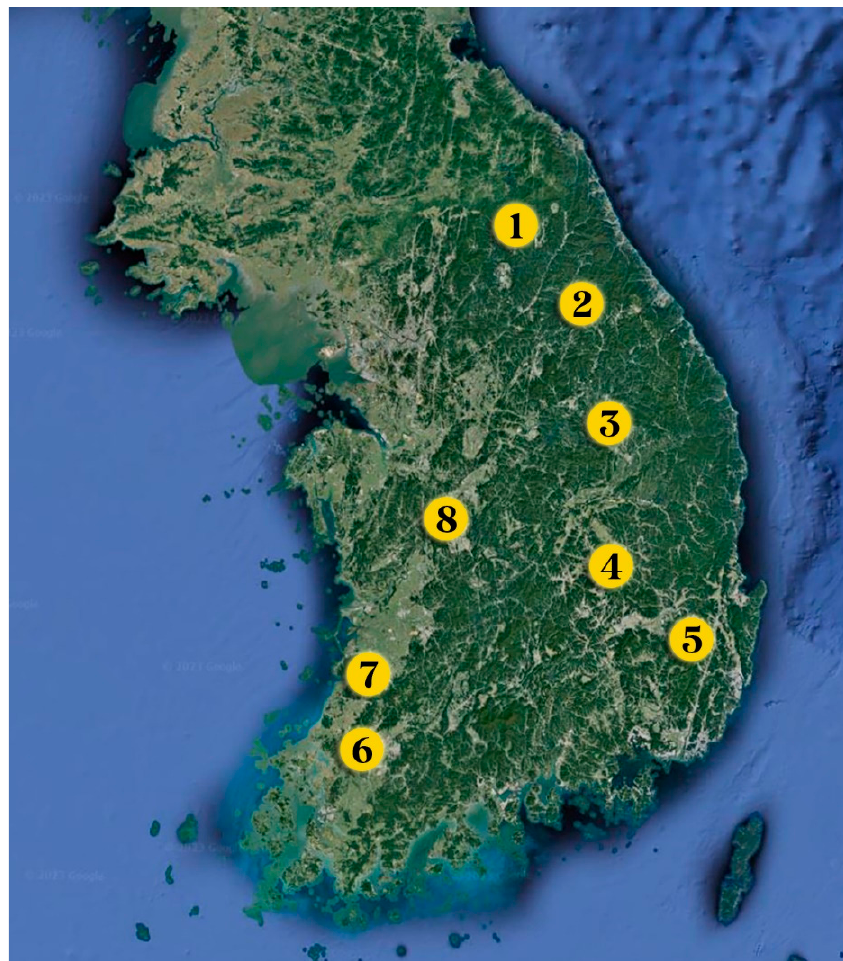
Figure 1. SoopCheWon and Forest Healing Center locations. (1: Chuncheon SoopCheWon, 2: